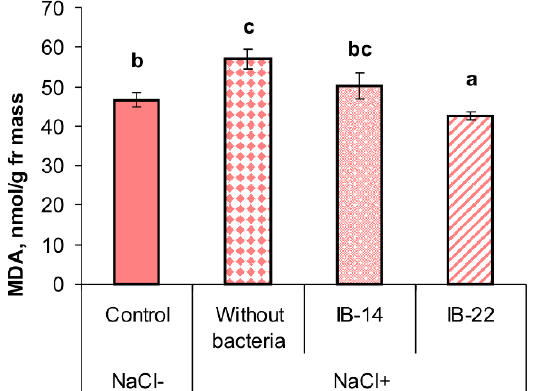
Figure 6. E ff ects of 100 mM NaCl and rhizospehere inoculation with P. mandelii IB -Ki14 (IB-14) Figure 6. Effects of 100 mM NaCl and rhizospehere inoculation with P. mandelii IB -Кi14 (IB-14) and and B. subtilis IB -22 (IB-22) on MDA content in 13-days-old wheat plants. Control—option without bacterization and salinity. Significantly di ff erent means for each variable are labeled with di ff erent letters ( n = 6, p ≤ 0.05; LSD test).